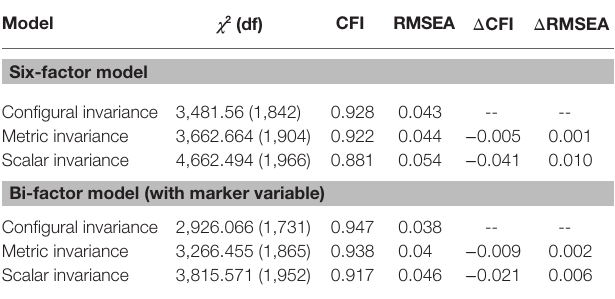
TABLE 3 | Measurement invariance test of the measurement model across the three